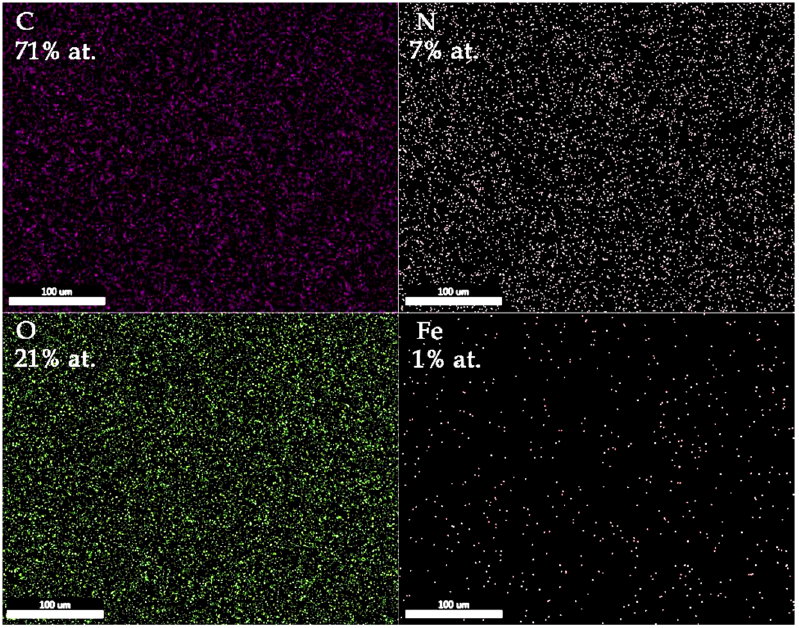
Figure 3. SEM- EDS elemental mapping of PANI-IO thin film. Figure 3. SEM-EDS elemental mapping of PANI-IO thin film. Figure 3. SEM-EDS elemental mapping of PANI-IO thin